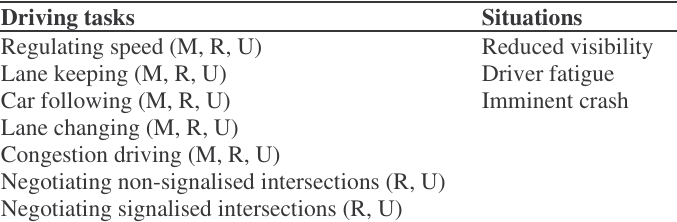
Table 1. Driving tasks and situations in the survey